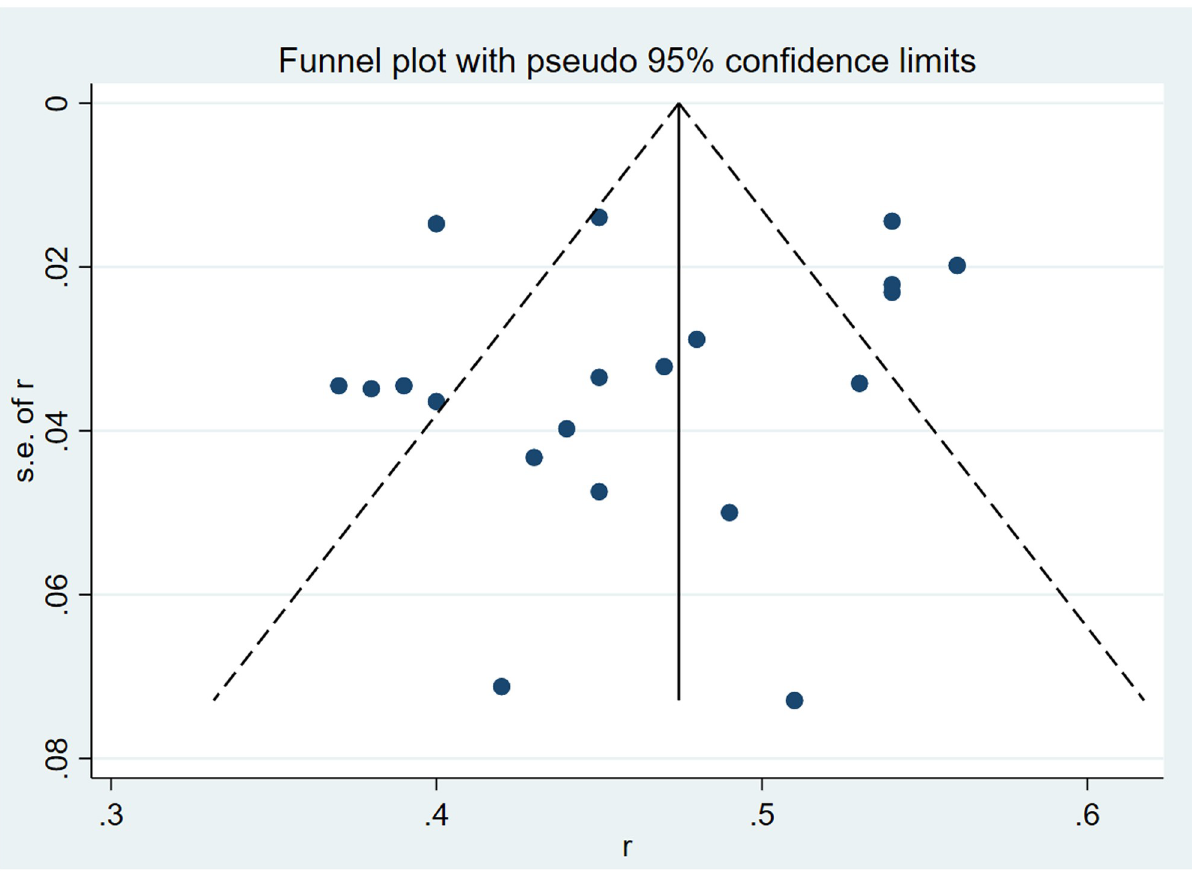
Fig 4. Funnel plot of literature publication bias on malnutrition prevalence in patients with chronic heart failure.